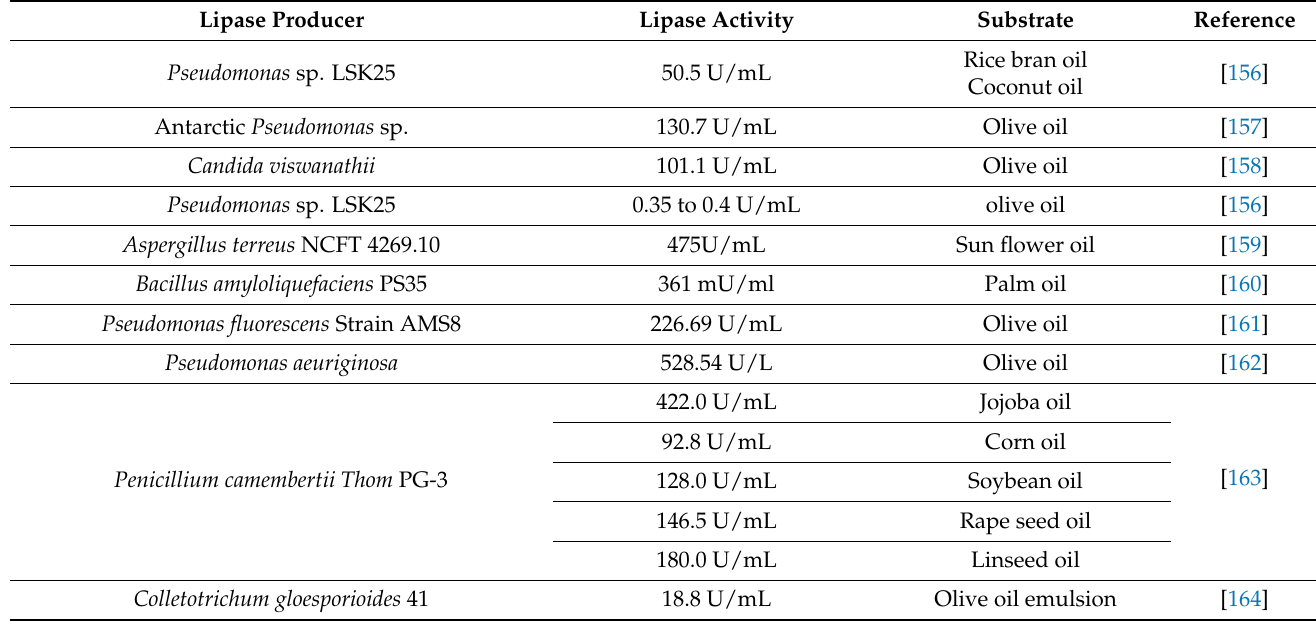
Table 3. Microbial production of lipase on different substrates.